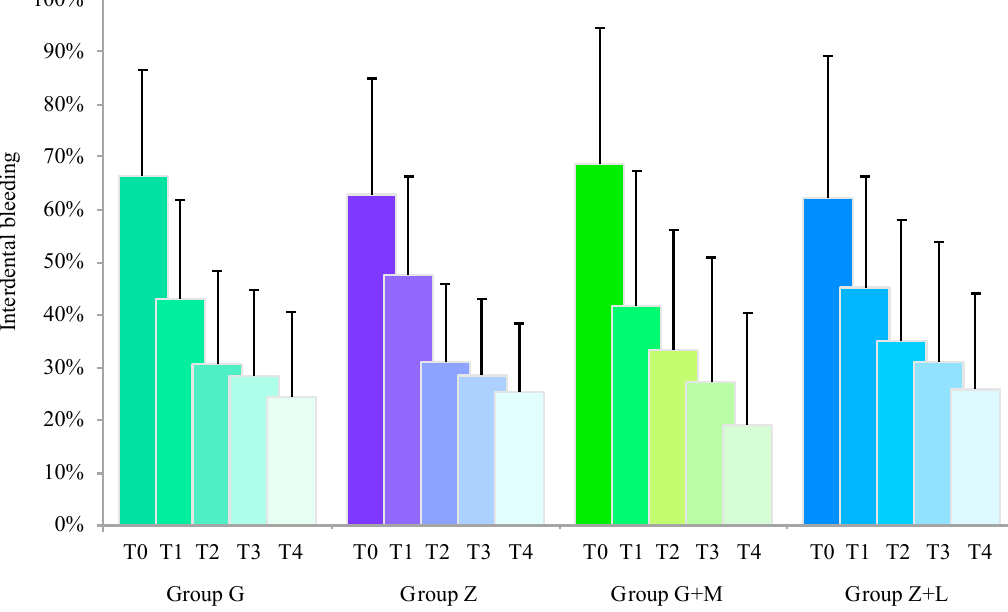
Figure 2. Evolution of interproximal bleeding by group in 2273 interdental sites (100 subjects). Group G: test Carica papaya leaf extract (CPLE) dentifrice; Group G + M: test CPLE dentifrice with CPLE mouthwash; Group Z: control with sodium lauryl sulfate (SLS)-free enzyme-containing dentifrice; Group Z + L: control with SLS-free enzyme-containing dentifrice and alcohol-based essential oil mouthwash; T 0 : basal; T 1 : 1 week; T 2 : 2 weeks; T 3 : 3 weeks; T 4 : 4 weeks.